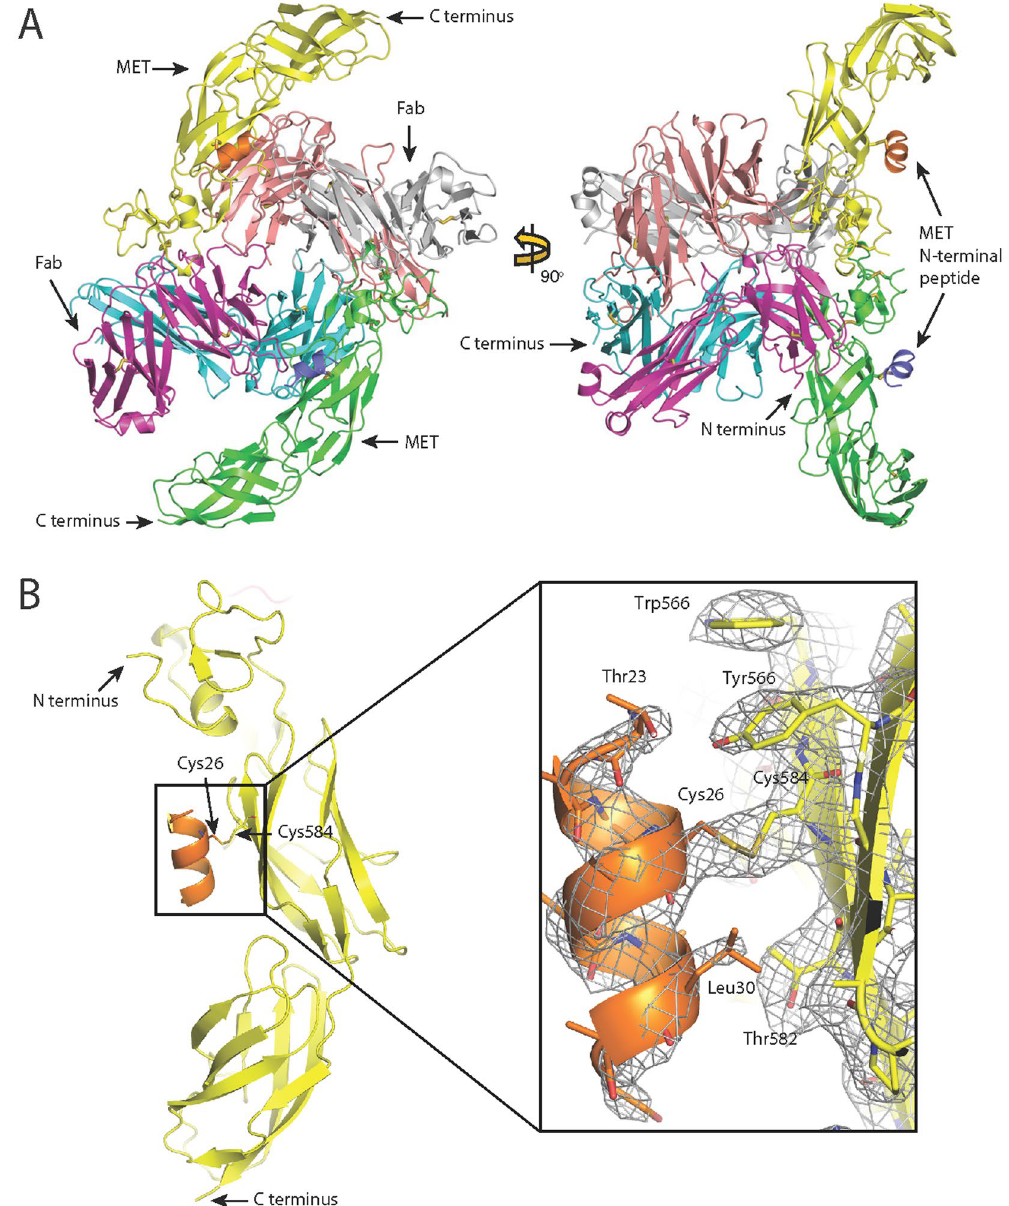
Figure 4. Crystal structure of the 107_A07-MET complex. A : Content of the asymmetric unit. The two views are related by a 90° rotation along the y axis. Complex molecule 1: MET receptor fragment (519–740) – green; MET receptor amino terminal peptide (22–32) – violet; 107_A07 Fab heavy chain – cyan; 107_A07 Fab light chain – magenta. Complex molecule 2: MET receptor fragment (519–740) – yellow; MET receptor amino terminal peptide (22–32) – orange; 107_A07 Fab heavy chain – salmon pink; 107_A07 Fab light chain – grey. The disulfide bridges are shown as sticks. The figure was generated with PYMOL 62 . B : The view showing the position of MET receptor amino-terminal peptide in orange (22–32) relative to MET receptor fragment in yellow (519–740). The disulfide bridge between residues Cys26 of the peptide and Cys584 of MET receptor fragment is shown in sticks. The zoomed in portion of the figure is showing the final 2Fo-Fc electron density map contoured at 1.1 sigma